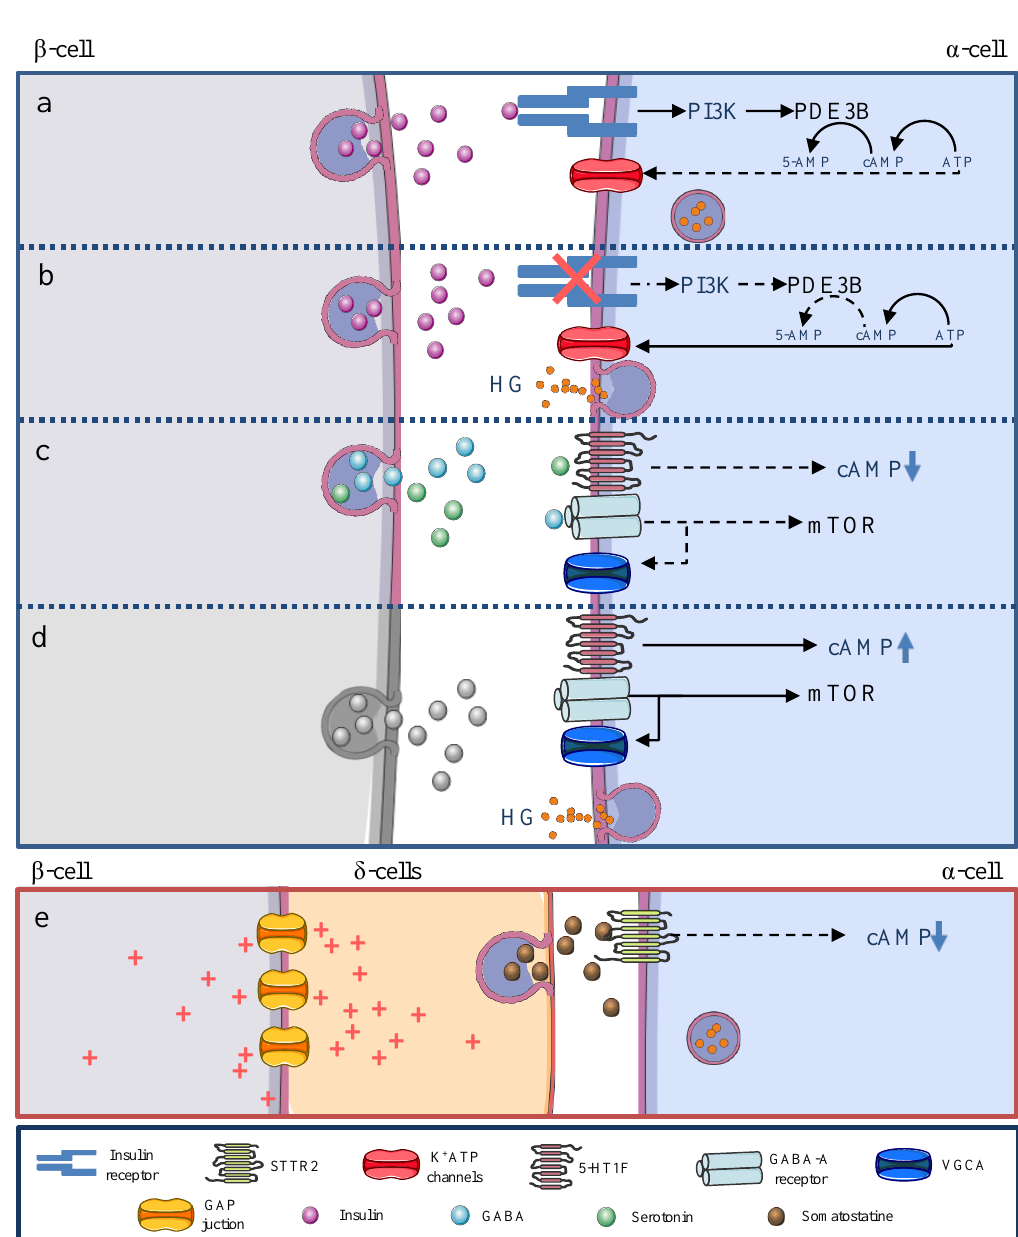
Figure 2. Paracrine regulation of glucagon secretion. ( a ) Insulin signalling in α cell regulates glucagon secretion. It has been proposed that sequential phosphatidylinositol 3-kinase (PI3K) and phosphodiesterase-3B (PDE3B) activation drive a fall in AMP-c concentration and a reduced ATP binding capacity K ATP , blocking glucagon secretion. ( b ) The insulin receptor-coding gene deletion in α cell drives to hyperglycaemia and hyperglucagonemia via ATP accumulation. ( c ) GABA and serotonin from β cells inhibit glucagon secretion. GABA-A receptors under non-pathologic conditions trigger α cell hyperpolarization with VGCA closure and rapamycin target kinase in mammalian cells (mTOR) inactivation, one of the primary regulators of α cell proliferation. Serotonin via 5-HT1F membrane receptor activation leads to cAMP reduction, inhibiting, therefore, glucagon release. ( d ) Consequently, any impairment on their secretion could be linked to an increase in α cell mass and hyperglucagonemia in diabetes. ( e ) β cells glucose-mediated depolarization cause coupled- δ -cells depolarization, activating somatostatin secretion, subsequent α cell hyper-polarization, and inhibition of glucagon release by somatostatin receptor 2 (STTR2)